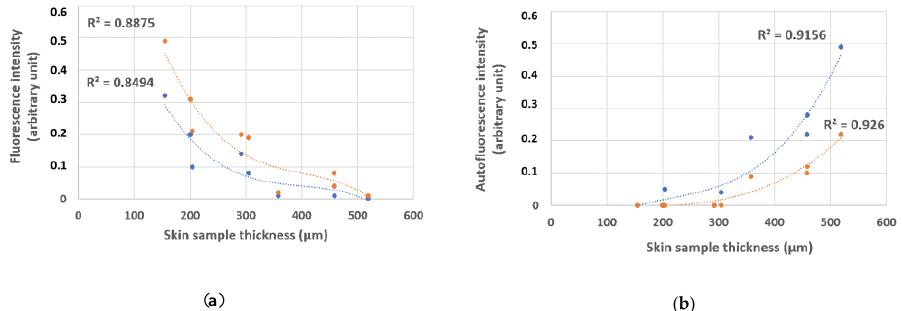
Figure 9. AGuIX ® nanoparticles fluorescence ( a ), and ex vivo human skin autofluorescence ( b ) peak intensity for two excitation wavelengths (blue: 365 nm, and orange: 405 nm) by the SpectroLive device.